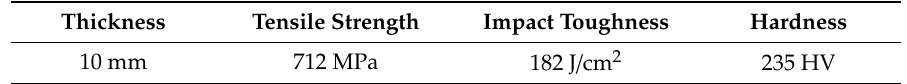
Table 2. Mechanical properties of 304 stainless